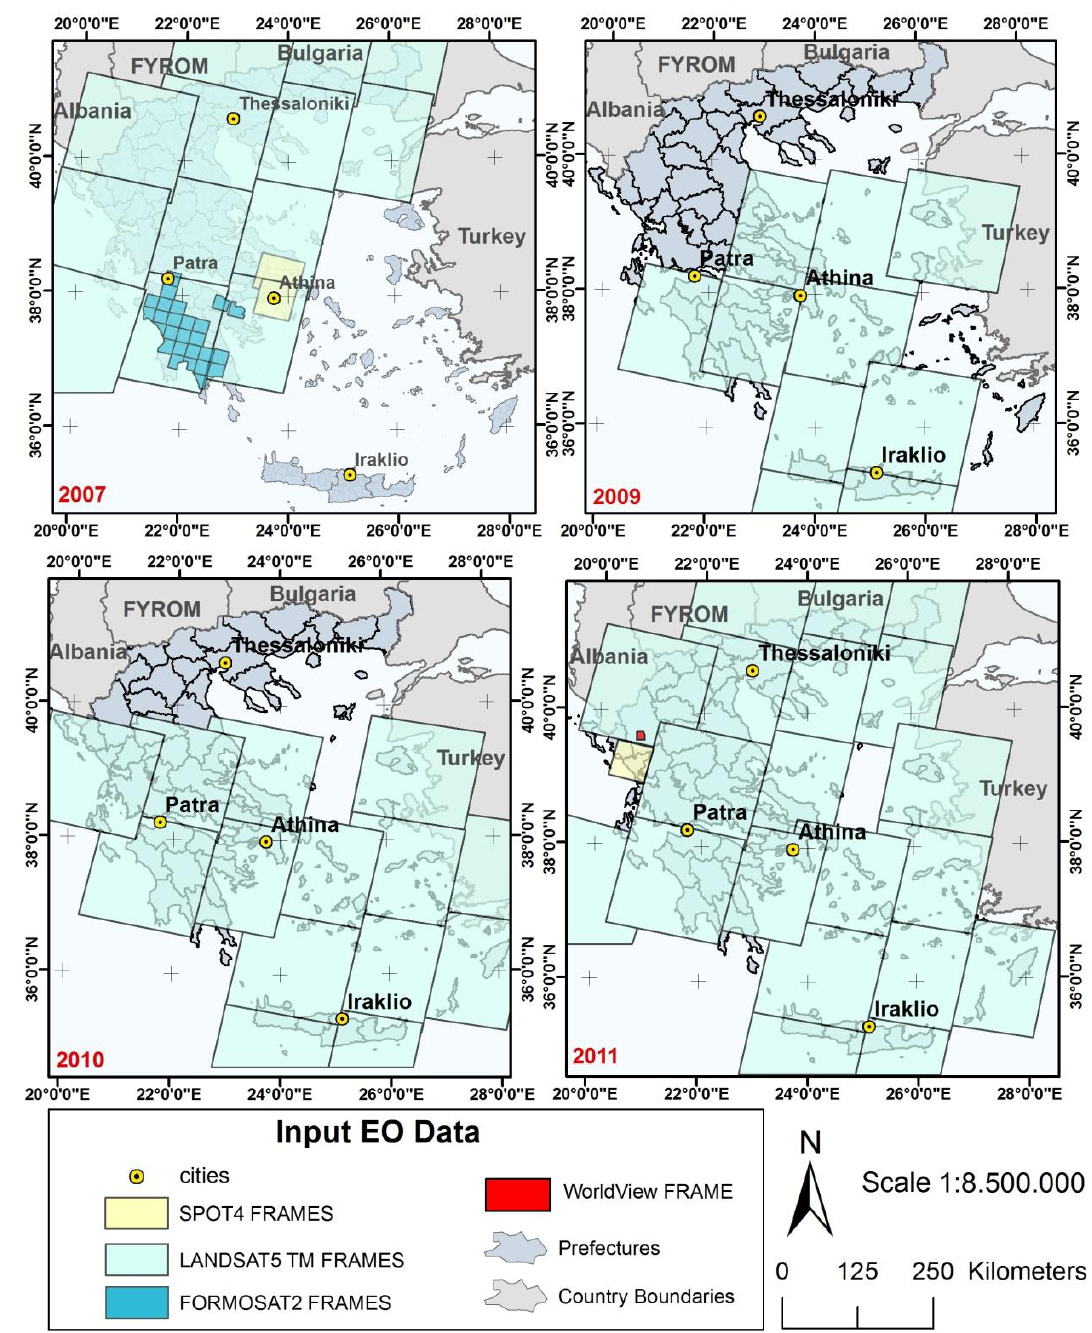
Figure 1. Satellite frames for burnt area mapping in 2007 ( Upper Left ), 2008–2009 ( Upper Right ), 2010 ( Bottom Left ) and 2011 ( Bottom Right